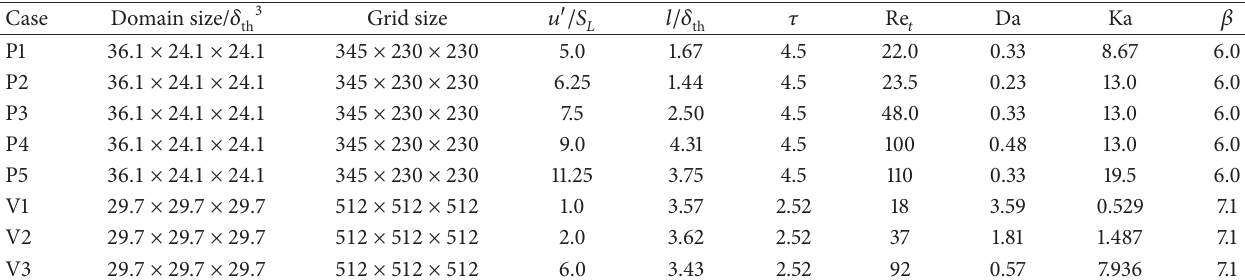
Table 1: Initial values of simulation parameters and nondimensional numbers relevant to the DNS database considered here.